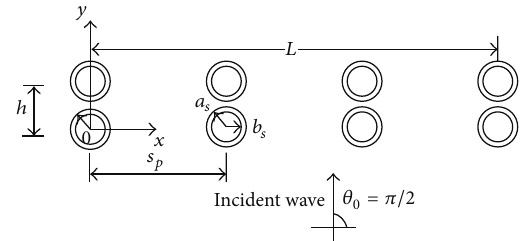
Figure 13: The reference system and analysis model of incident plane waves scattering by multirows of tubular piles (rectangular arrangement, 𝑁 = 8